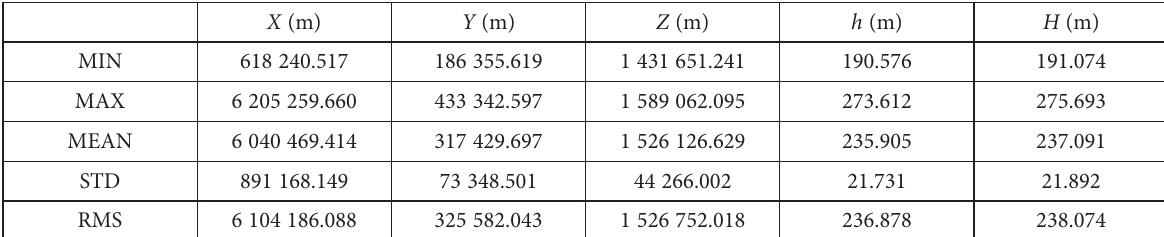
Table 2. Statistics of coordinates on WGS84 released by